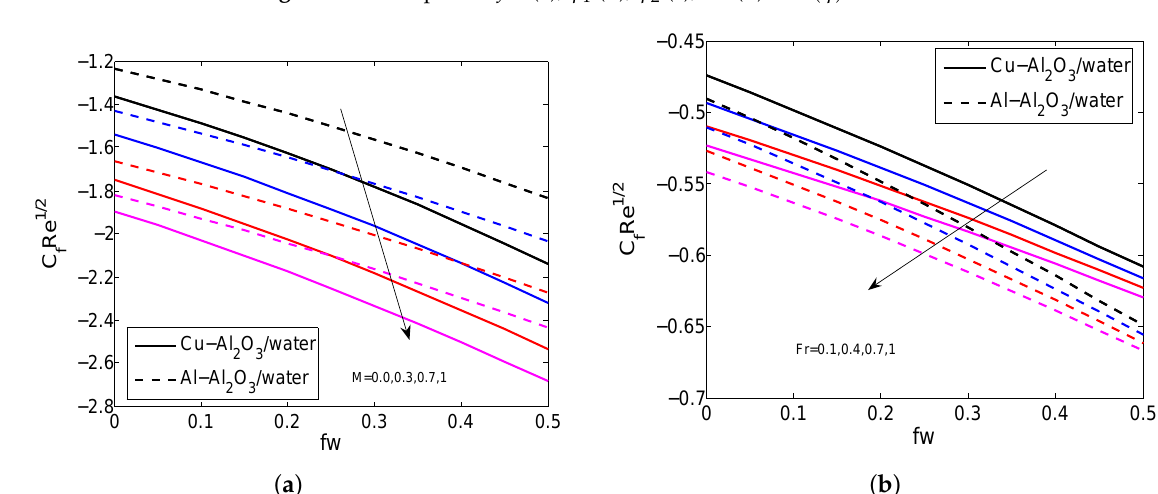
Figure 4. The impact of fw , M and Fr on SFC for both